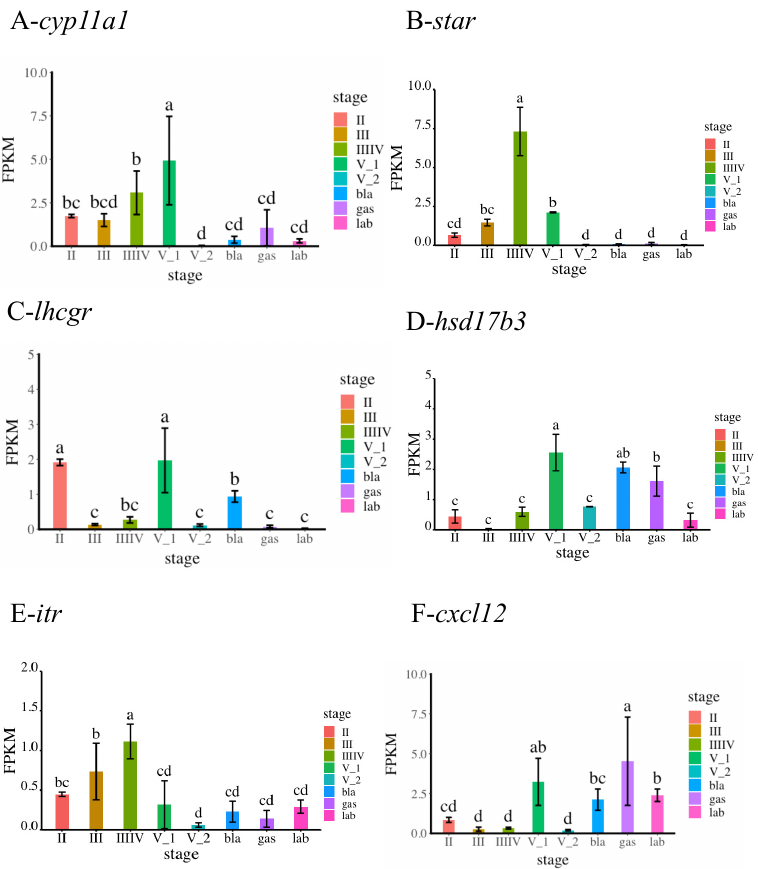
Figure 7. Validation of the DEGs by RT-qPCR. The expression levels of cyp11a1 , star , lhcgr , hsd17b3 , itr, and cxcl12 during different developmental stages were detected by RT-qPCR. For reference genes, 18S were used for normalization of RT-qPCR data. Bars represent the standard deviation (SD). The x-axis indicates the developmental stage. The y-axis shows the relative expression level of genes. A: cyp11a1 ; B: star ; C: lhcgr ; D: hsd17b3 ; E: itr ; F: cxcl12 .